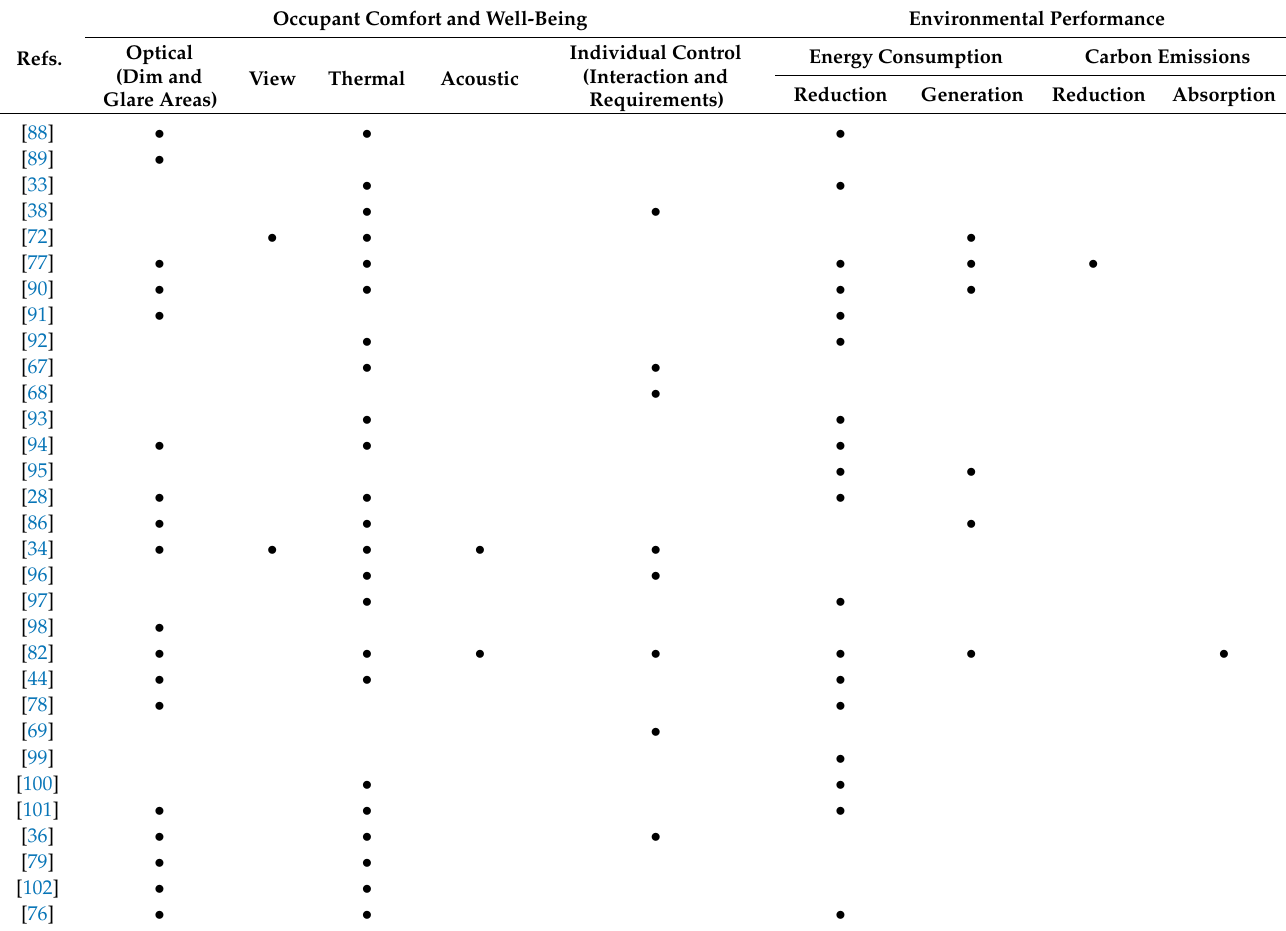
Table 1. Aspects addressed in the literature on the performance evaluation of AFs.